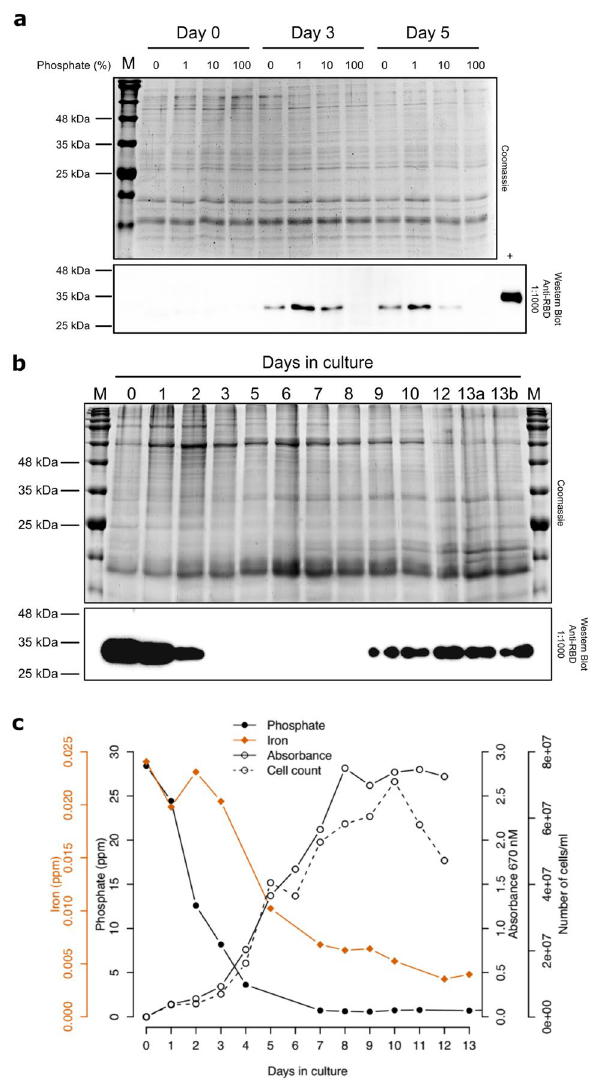
Figure 3. Phosphate-regulated expression of algae codon-optimized RBD from the HASP1 promoter. ( a ) RBD expression in response to varying phosphate concentrations measured over time. Shown is a coomassie-stained gel (top) of whole cell extracts from cultures harbouring pSS2 at day 0, 3 and 5 post inoculation into media with 0%, 1%, 10% or 100% of phosphate (Supplementary Table 3). RBD expression was assessed by western blotting (bottom) using a polyclonal anti-RBD antibody. The positive control (+) is 5 ng of commercially available RBD purified from HEK293 cells. M, BLUelf Prestained Protein Ladder. ( b ) RBD expression in a 5 L bioreactor. The top image is a coomassie-stained gel of whole cell lysates sampled at the indicated day, while the bottom image is a western blot using a polyclonal anti-RBD antibody. M, BLUelf Prestained Protein Ladder. ( c ) Plot of phosphate (filled circles) and iron (filled diamonds) as a function of growth over (open circles, solid line) and cell number (open circles, dashed line) over time in a photobioreactor. Phosphate and iron are plotted as parts per million (ppm), growth is plotted as absorbance readings at A670 nM, and cell number as cell count per mL of culture. Uncropped gel images for panels ( a ) and ( b ) are shown in Supplementary Figures